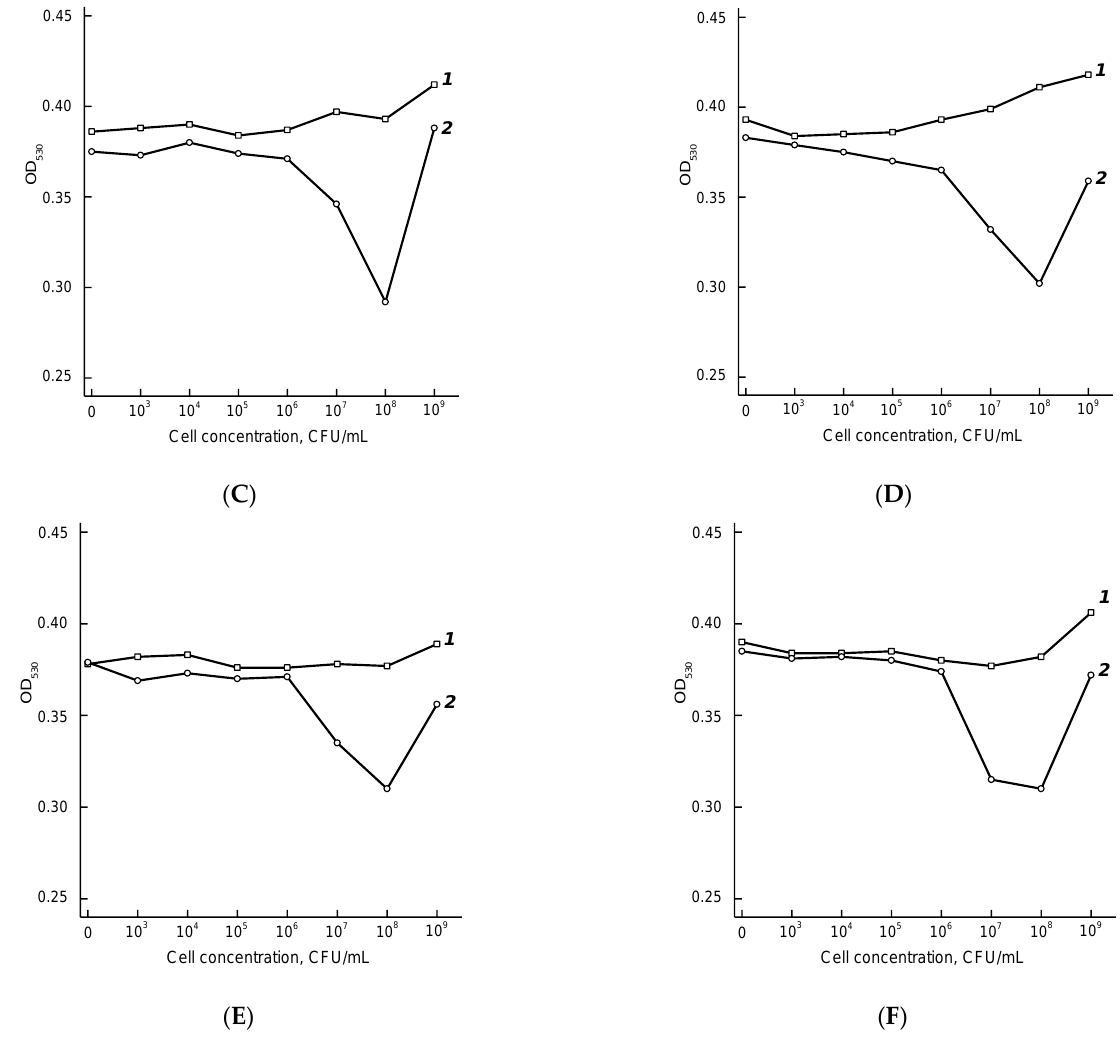
Figure 4. Agglutination of AuNPs2–Fb11 conjugate in the presence of various concentrations of thermally inactivated F. tularensis subsp. holarctica 15 NIIEG ( A ) and 503 ( B ), F. tularensis subsp. mediasiatica 120 ( C ), F. tularensis subsp. tularensis Schu ( D ) and A-Cole B-399 ( E ), and F. tularensis subsp. novicida Utah112 ( F ). Curves 1 and 2 correspond to 1 and 20 min of the reaction. Table 5 summarizes the minimum detectable cell concentrations of various F. tularensis strains. As can be seen, the LOD varies from 1 × 10 6 to 5 × 10 7 CFU/mL when using the AuNPs2–Fb11 conjugate and from 5 × 10 4 to 5 × 10 6 CFU/mL when using the AuNPs2– T143 conjugate. The AuNPs2–T143 conjugate does not agglutinate in the presence of the non-virulent F. tularensis novicida Utah112 strain, which enables distinguishing virulent and non-virulent F. tularensis strains. Specificity of the assay to heterologous LPS preparations from Yersinia enterocolitica 287 and Salmonella spp. and cells of Y. enterocolitica H-26-04, Y. pseudotuberculosis 4320, Pseudomonas aeruginosa ATCC27853, and Brucella abortus was determined using the AuNPs2– T143 conjugate. Results presented in Figure S10 demonstrated that the AuNPs2–T143 conjugate did not bind to the above-mentioned heterologous antigens. Calibration dependences for F. tularensis LPS (Figure 6A) and F. tularensis subsp. holarctica 15 NIIEG cells (Figure 6B) were obtained in the chosen optimal assay conditions. The LODs were 40 ng/mL for LPS and 3 × 10 4 CFU/mL for F. tularensis cells, and the detection accuracy (RSD) was